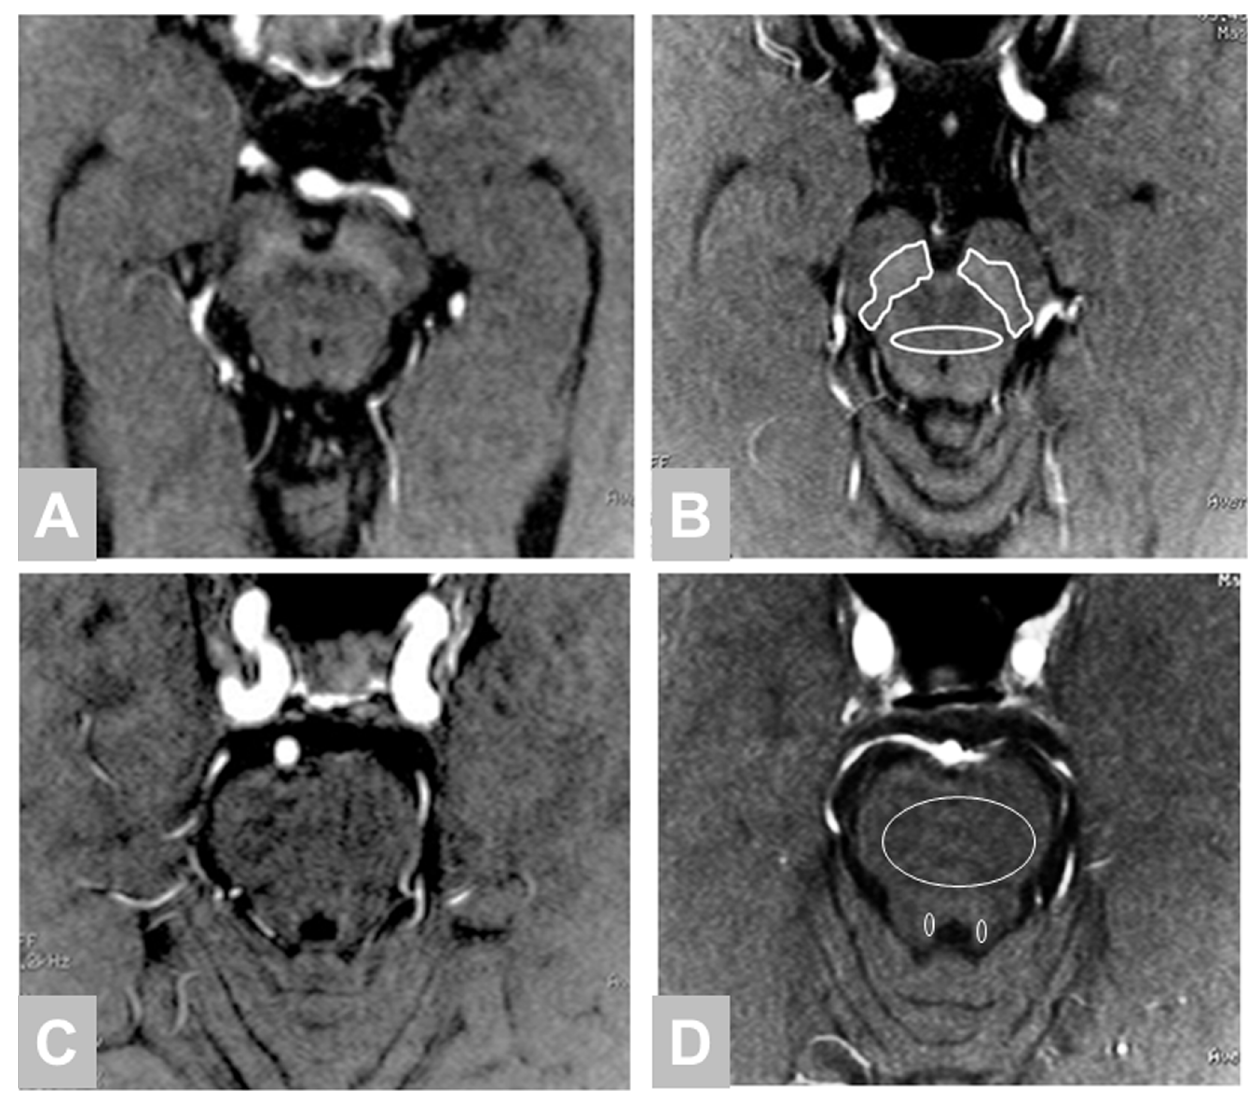
Figure 1. Neuromelanin imaging in the midbrain. A, C: 30-year-old male with schizophrenia, CR SN =12.9, CR LC =10.7; B, D: 26-year-old female healthy control, CR SN =6.2, CR LC =7.6 Demonstrating a region of interest drawn around the substantia nigra and midbrain tegmentum side on Figure 1B and locus ceruleus on Figure 1D.